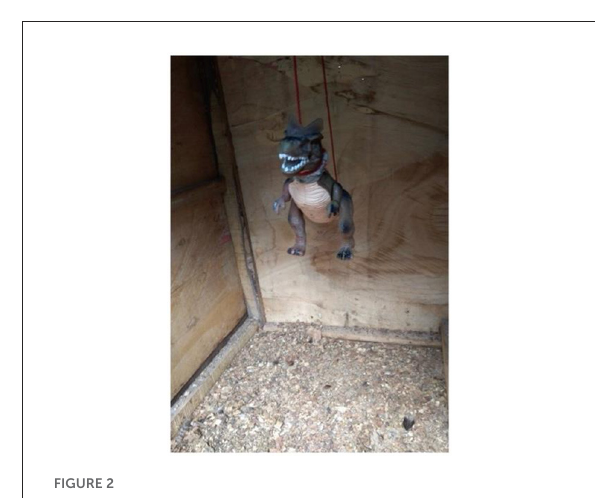
FIGURE2 Simulated predator hung in the test